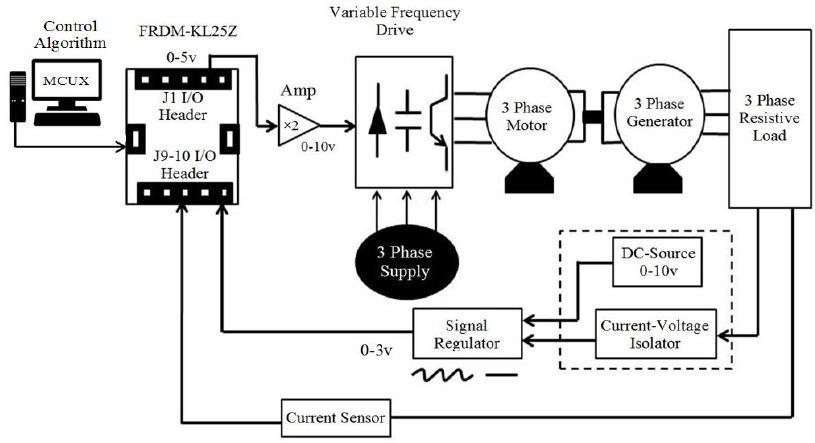
Figure 4. Closed-loop control diagram of variable speed motor application.